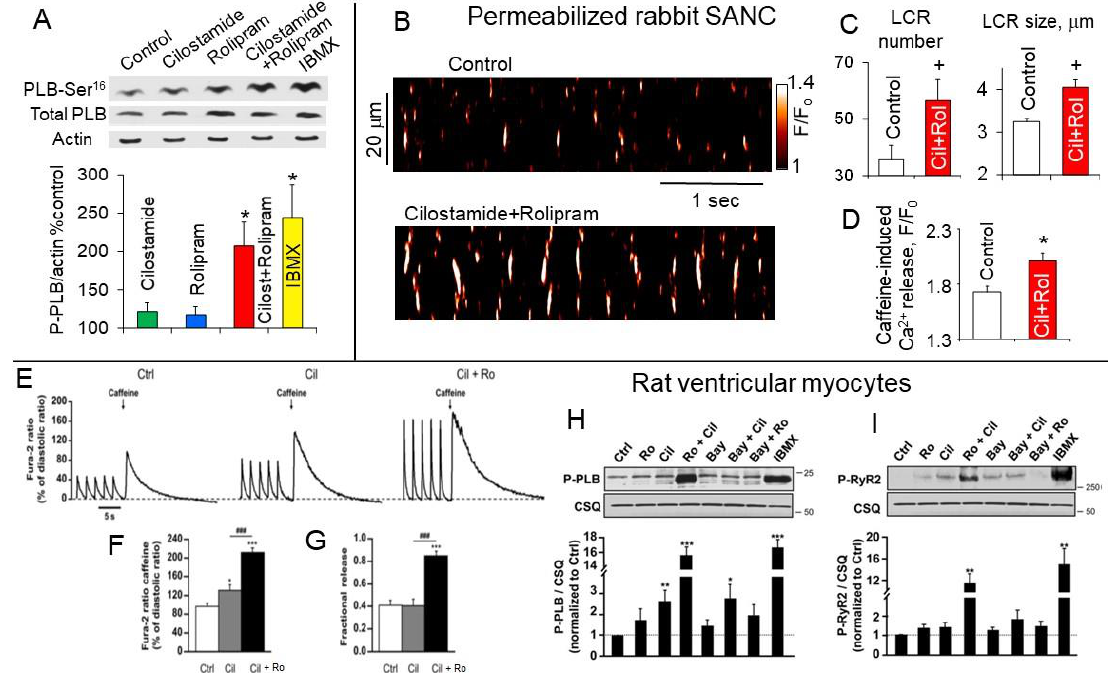
Figure 8. ( A ) Top, representative western blots of total and phosphorylated PLB at PKA-dependent Ser 16 site in rabbit SANC before and after application of 0.3 µmol/L cilostamide or 2µmol/L rolipram alone or combination of cilostamide + rolipram or 100 µmol/L IBMX. Bottom, average changes in phosphorylated PLB at Ser 16 site and expressed as % of control (n = 7–9 rabbits). One-way ANOVA with Tukey’s post-hoc test, * p < 0.05 vs. cilostamide or rolipram alone. ( B ) Confocal line-scan images of representative saponin-permeabilized rabbit SANC prior to and during dual PDE3 + PDE4 inhibition. ( C ) Average changes in the LCR number (left) and size (right) produced by 2-min superfusion with 0.3 µmol/L cilostamide and 2 µmol/L rolipram. ( D ) SR Ca 2+ content was estimated by rapid application of caffeine on permeabilized SANC in the absence or presence of dual PDE3 + PDE4 inhibition. Compared to control group dual PDE3 + PDE4 inhibition markedly increased caffeine-induced SR Ca 2+ release. t -test: + p < 0.01; * p < 0.05; ( A – D , from [11]). (E-I, with permission, from [9]). ( E ) Effect of concomitant PDE3 and PDE4 inhibition on SR Ca 2+ load and fractional release in rat ventricular myocytes. Representative traces of Ca 2+ transients obtained with caffeine (10 mM) recorded in Fura-2 loaded rat ventricular myocytes after pacing at 0.5 Hz, under basal conditions (Ctrl), upon PDE3 inhibition by cilostamide (Cil, 1 µmol/L), or PDE3 and PDE4 inhibition by cilostamide and Ro20-1724 (10 µmol/L) (Ro + Cil). ( F ) Mean amplitude (±SEM) of calcium transients induced by caffeine (10 mM) estimating SR Ca 2+ content in Ctrl (white bar, n = 8 cells, 3 rats), Cil (grey bar, n = 8 cells, 3 rats), and Cil + Ro (black bar, n = 9 cells, 3 rats). ( G ) Average fractional release (+SEM) in Ctrl (white bar, n = 8 cells, 3 rats), Cil (grey bar, n = 8 cells, 3 rats), and Cil + Ro (black bar, n = 9 cells, 3 rats). Statistical significance is indicated as: * p <0.05; *** p < 0.001 (vs. control cells), and ### p < 0.001 (vs. Cil treated cells) (one-way ANOVA, Newman – Keuls). ( H ) phospho-PLB (P-PLB) and ( I ) phospho-ryanodine receptor (P-RyR2). The membranes were stripped and re-probed with CSQ anti-bodies used as a loading control. A representative blot is shown, and at least five separate experiments were performed